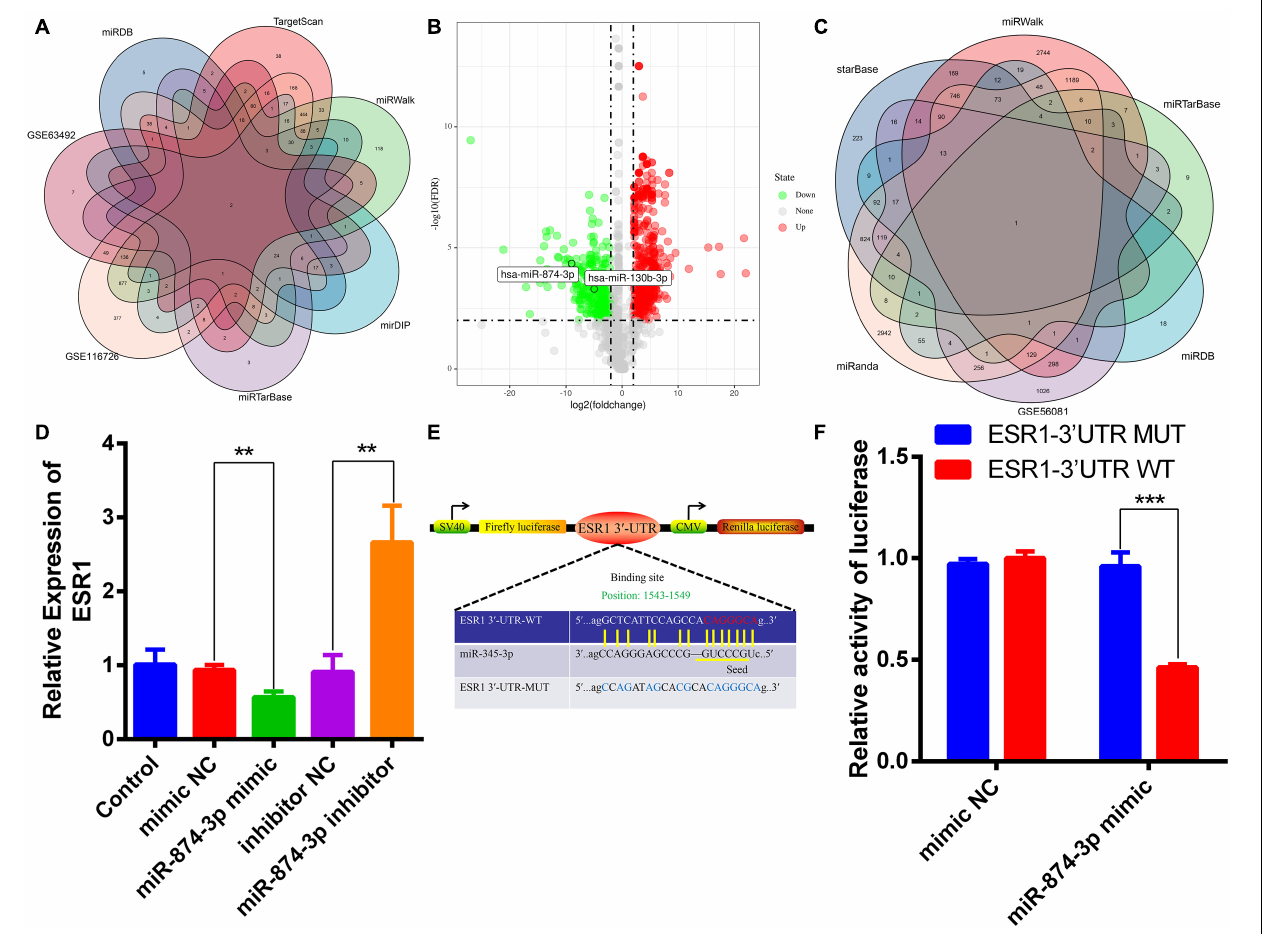
FIGURE 2 | MiR-874-3p was predicted to be the upstream miRNA of ESR1. (A) Upstream miRNAs of ESR1 were predicted using different algorithms. (B) Volcano plot shows the predicted upstream miRNAs of ESR1 based on the analysis of GSE116726. Green points represent downregulated miRNAs (left side), and red points represent upregulated miRNAs (right side); miR-874-3p and miR-130b-3p are presented. (C) Venn analysis of miR-874-3p downstream target genes using different algorithms. (D) ESR1 expression level was measured in NPCs after transfected with miR-874-3p mimic or miR-874-3p inhibitor or corresponding NCs using the qRT-PCR assay. (E) Binding site of miR-874-3p and ESR1. (F) Luciferase reporter vectors carrying ESR1 WT or MUT sequences were cotransfected into HEK-293T cells with miR-874-3p mimic or mimic negative control (NC). Relative luciferase activity was detected in HEK-293T cells. Data are represented as the mean ± SD. ** P < 0.01, *** P <